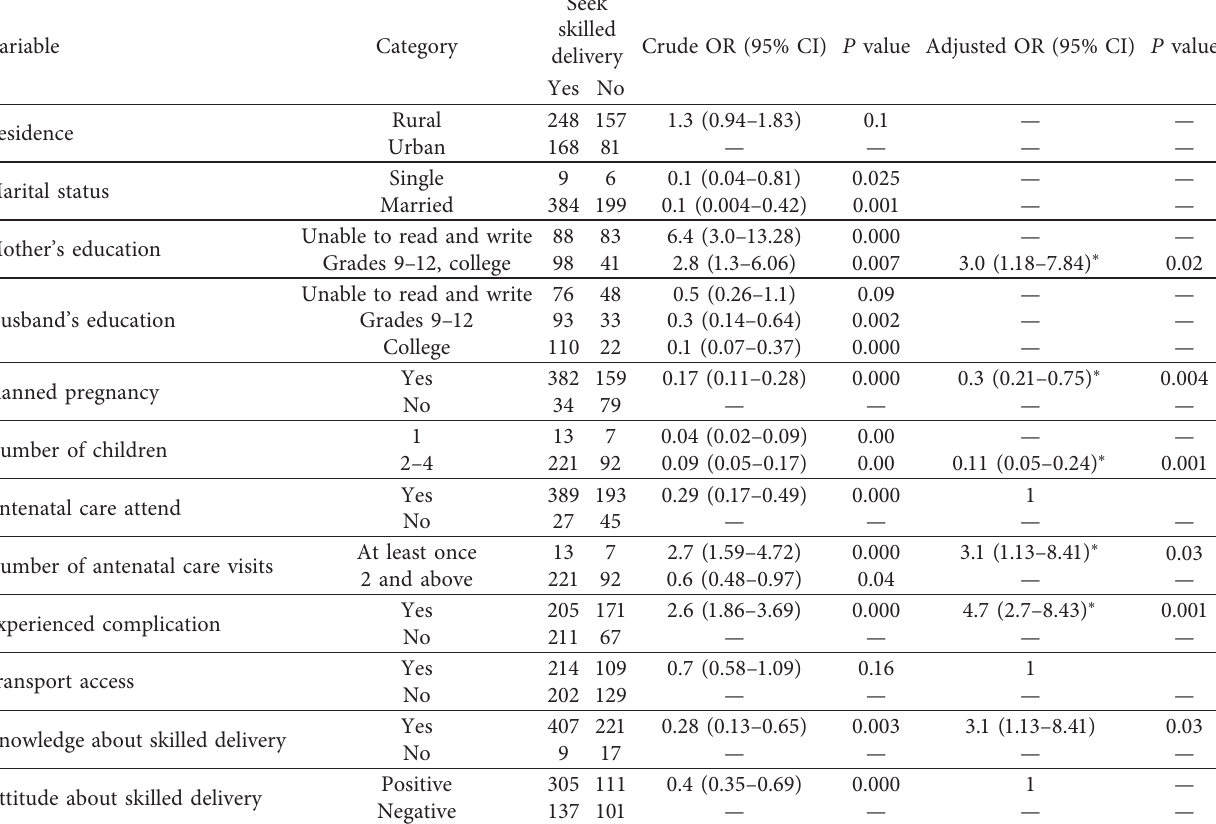
Table 6: Binary logistic regression model to examine the association of delivery services among study participants.